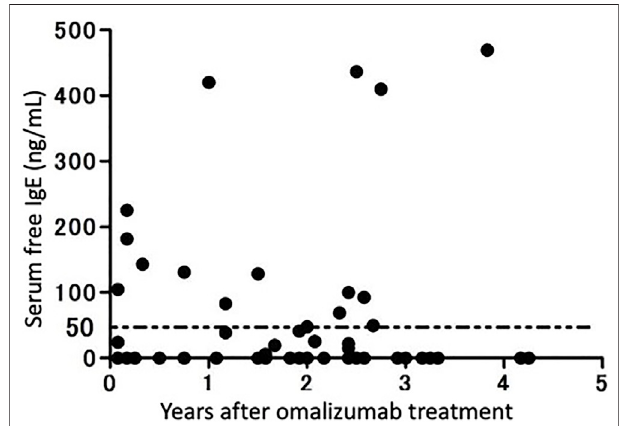
FIGURE 4 | Serum IgE levels in patients receiving omalizumab therapy. Serum free IgE levels in 54 patients receiving omalizumab therapy continuously for more than 1 year were measured using an enzyme-linked immunosorbent assay (modi fi ed from Ito et al., 2014).